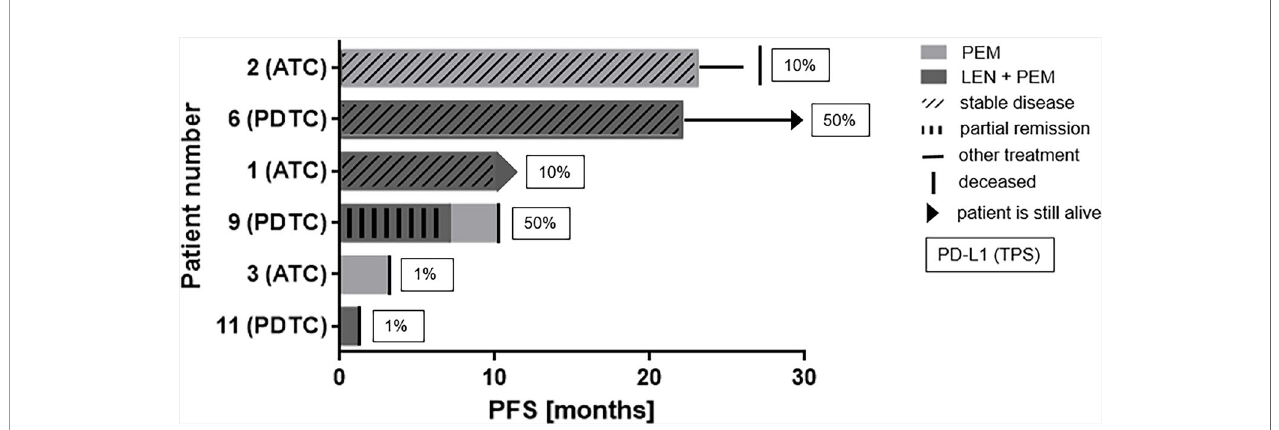
FIGURE 5 | Swim lane plot demonstrating PFS on PEM or the combination of LEN and PEM: Figure shows data before and after data cut-off. Patients 6 and 1 are still alive with patient 1 still receiving LEN + PEM. Exact date of progress or exact treatment duration was not reported because PD was always followed by change of therapeutic regimen or death. Progressive disease was the best response in patients 9 and 3 while on PEM monotherapy and in patient 11 receiving LEN +